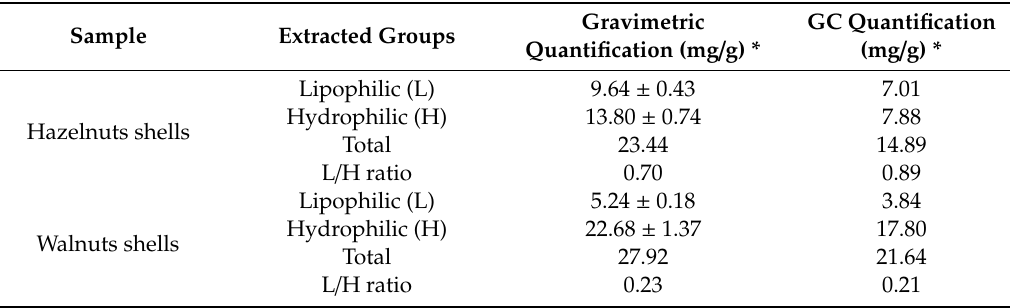
Table 1. Gravimetric analysis of lipophilic and polar